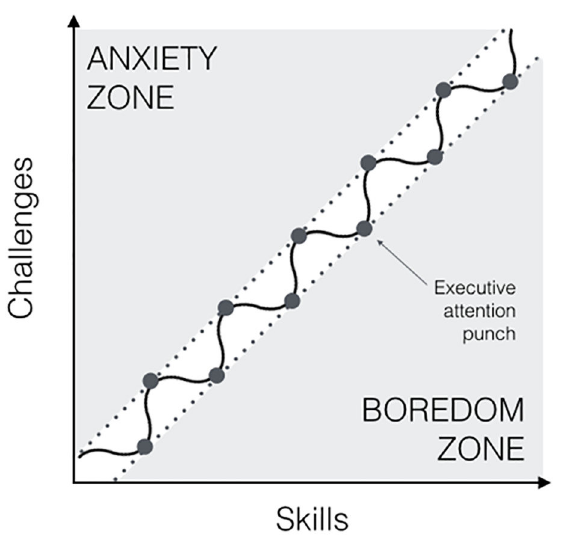
Figure 2. The flow channel and micro-disbalance between skills and